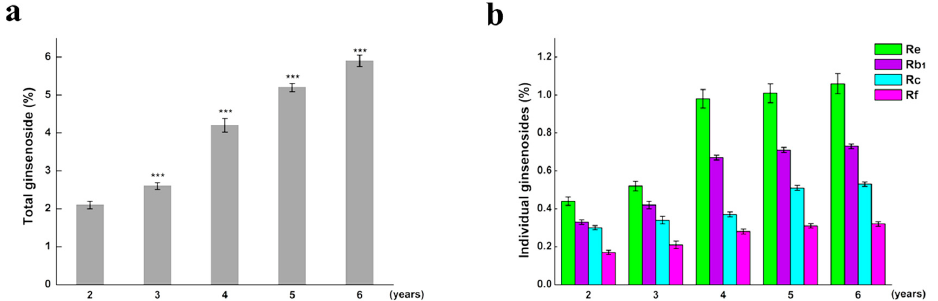
Figure 2. The total and monomer ginsenosides contents at different ages of fresh P. ginseng . ( a ) Total ginsenosides content; ( b ) Monomer ginsenosides content. (Tukey’s multiple comparison test, *** p < 0.001 vs. the previous year; n = 60).